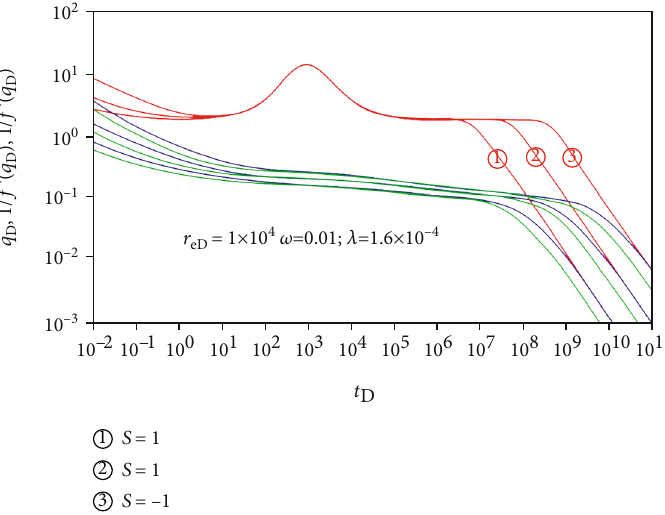
mf , on type curves.